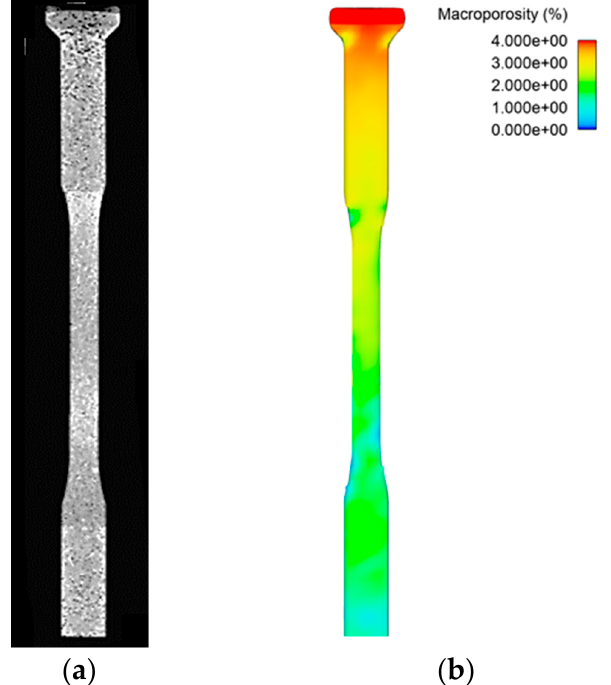
Figure 2. Macroporosity distribution across the top left tensile bar: ( a ) X-ray computed tomography and ( b ) CFD simulations.